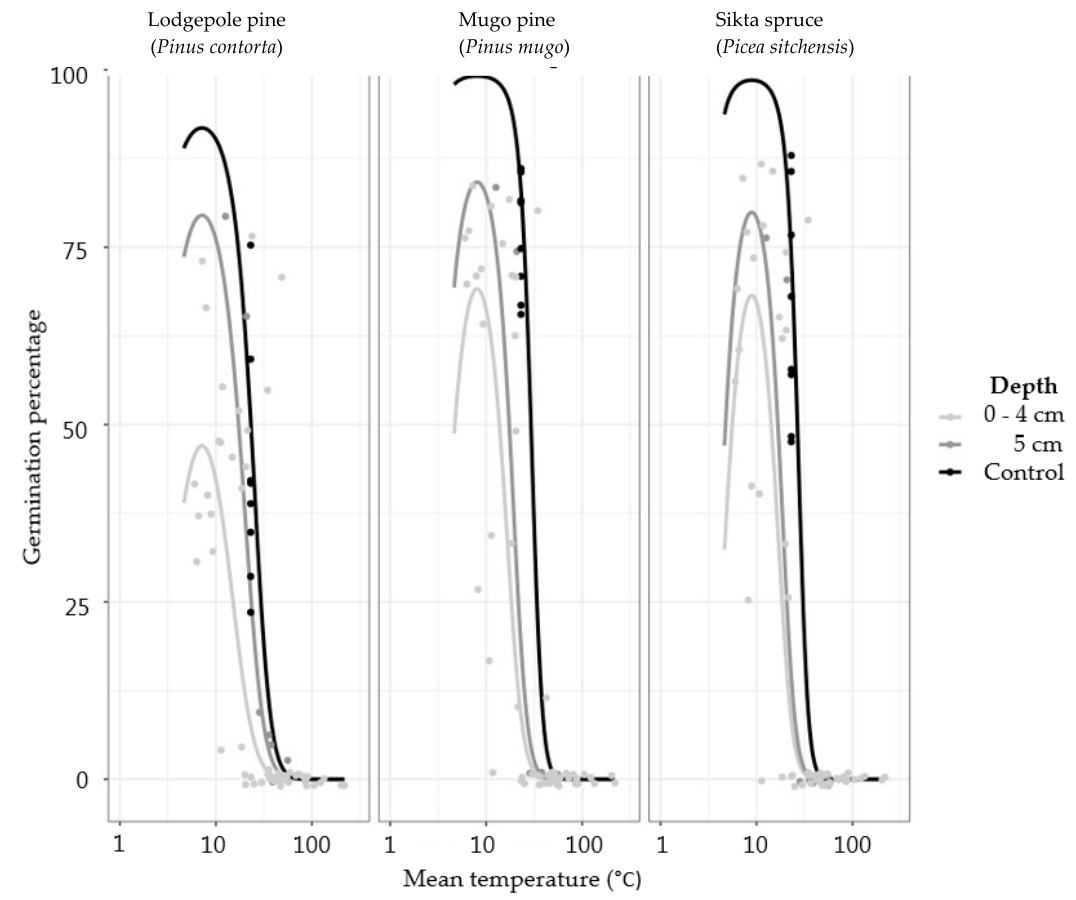
Figure 5. Fitted germination curves for lodgepole pine, mugo pine, and Sitka spruce, showing germination as a function of mean temperature for three di ff erent depths (0 − 4 cm, 5 cm, and the controls). Raw data (germination percentages) are also shown (as points).